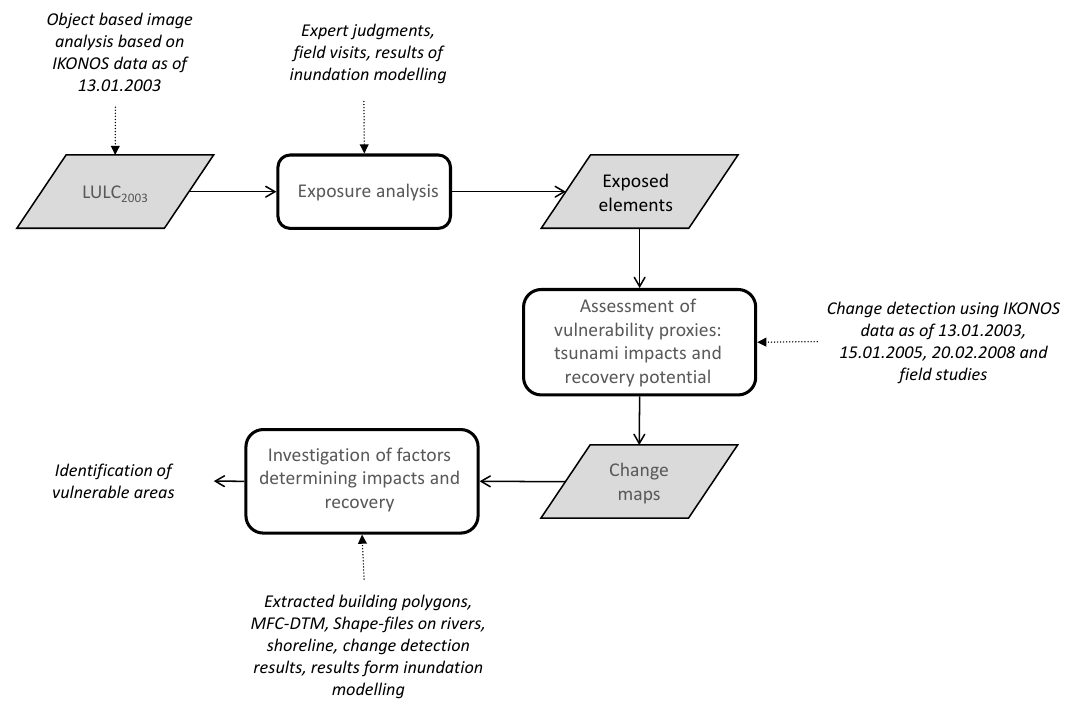
Fig. 5. Workflow applied to analyze ecological vulnerability.